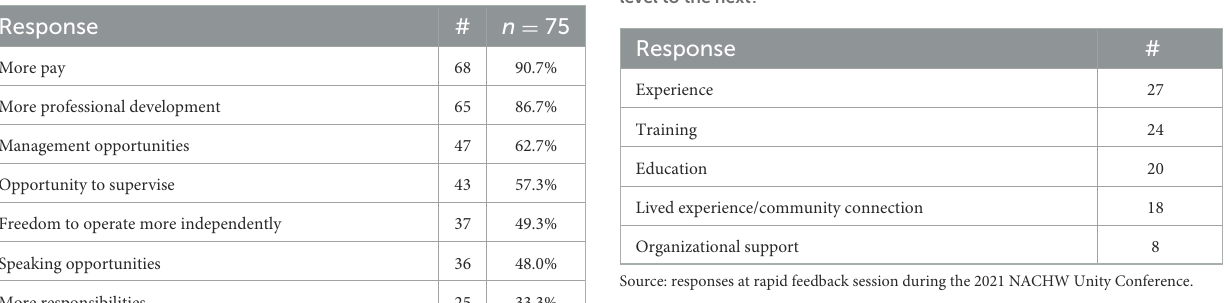
TABLE 4 Benefits CHWs believe should be available as they advance in their careers, in descending order.